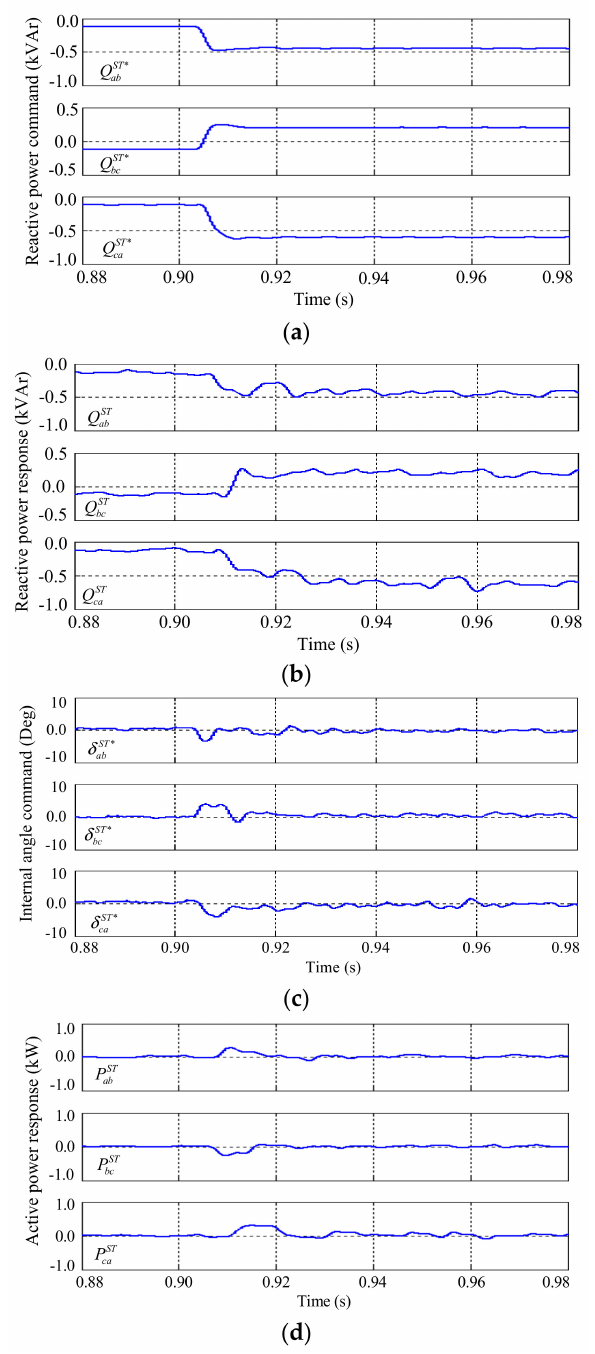
Figure 8. Controller responses of STATCOM ( a ) Each arm compensation command ( Q ST ∗ arm compensation response ( Q ST active power response ( P ST